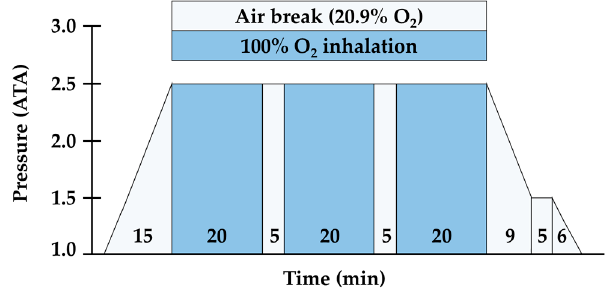
Figure 1. Hyperbaric oxygen therapy (HBOT) treatment protocol.